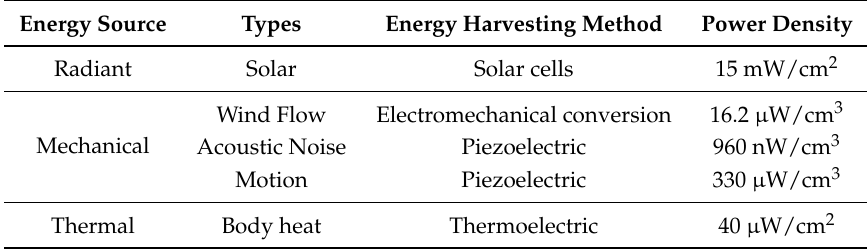
Table 1. The power densities of different energy sources